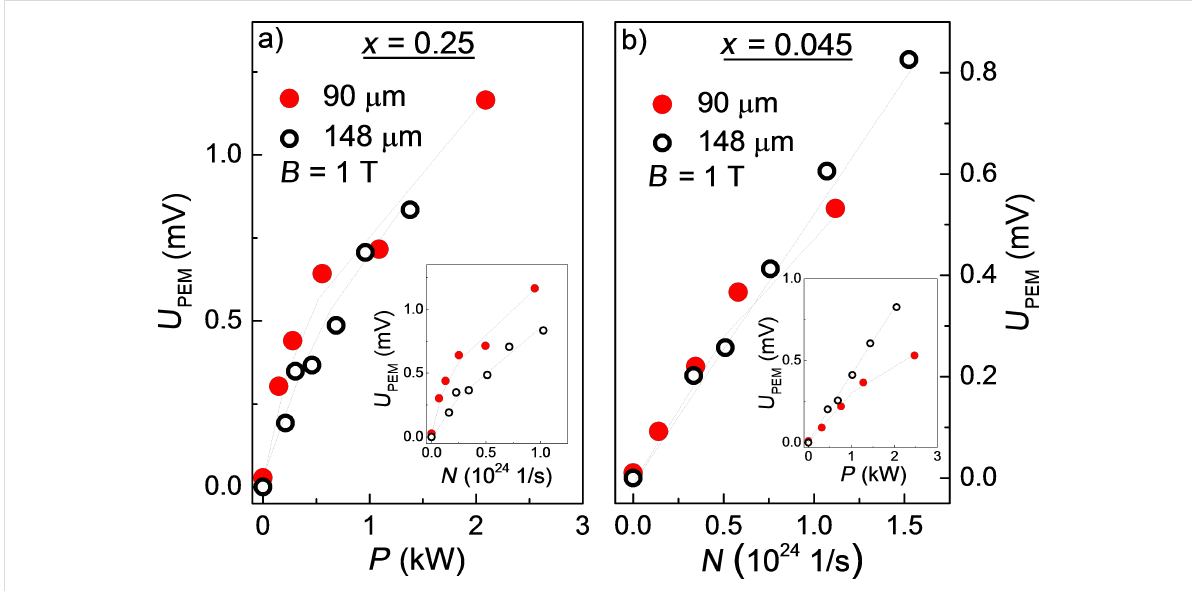
Figure 2: (a) Dependence of the PEM effect amplitude U PEM on the incident laser radiation power P at T = 4.2 K for laser wavelengths 90 and 148 μ m for a (Cd 0.75 Zn 0.25 ) 3 As 2 sample in trivial insulator phase. Inset: The same data plotted as PEM effect amplitude versus number of incident quanta N . (b) Dependence of the PEM effect amplitude on the flux of incident radiation quanta N at T = 4.2 K for laser wavelengths 90 and 148 μ m for a (Cd 0.955 Zn 0.045 ) 3 As 2 sample in the Dirac semimetal phase. Inset: The same data plotted as PEM effect amplitude versus incident radiation power P . The lines in the panels (a) and (b) are the guides for the eye.